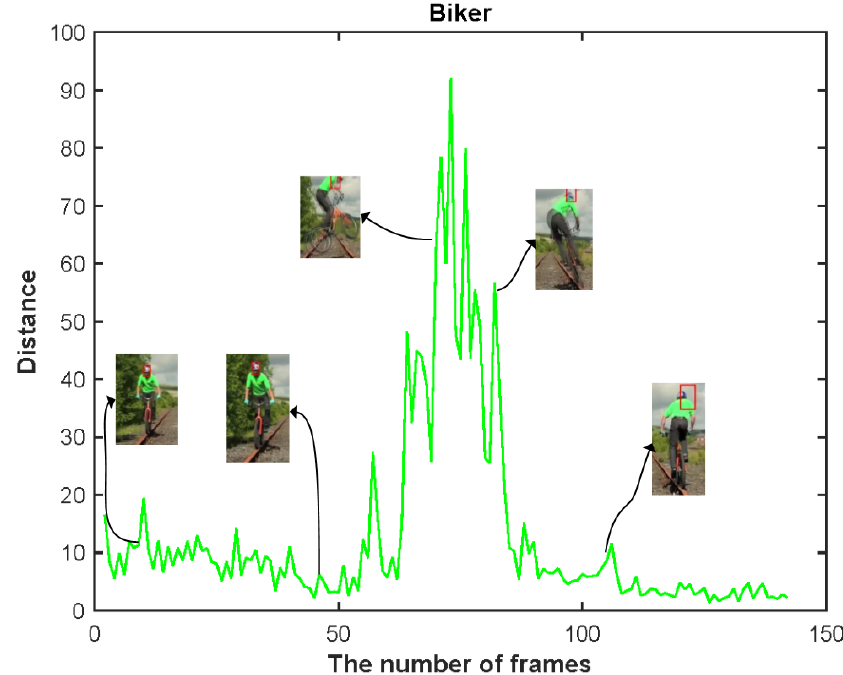
Figure 2. Visualization of the dynamic changes of the similarity distance on Biker. The tracking drift occurs when the target jumps around 70th frame. We can clearly observe that the similarity distance is significantly